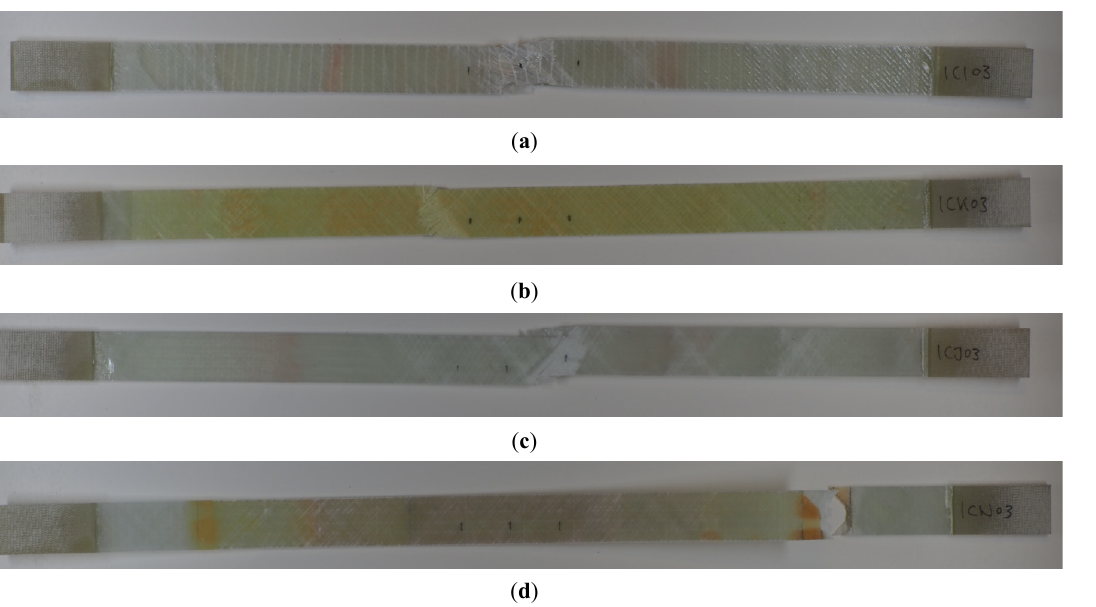
Figure 6. Cycle to failure for fatigue testing of peak strain 0.5%.